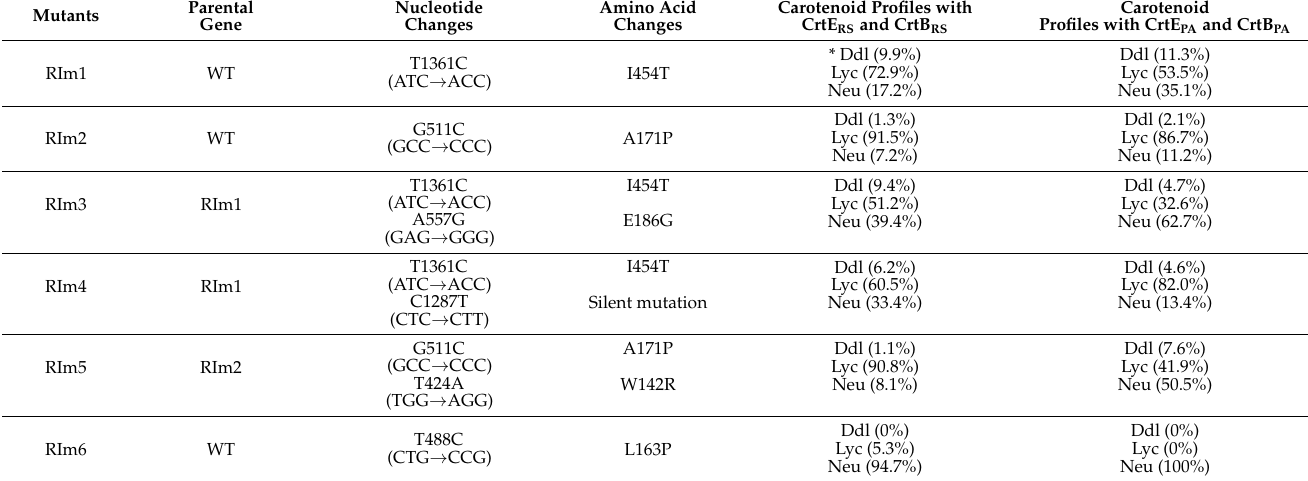
Table 2. CrtI RS mutants generated by random mutagenesis and altered carotenoid profiles when complemented with the R. sphaeroides CrtB RS and CrtE RS and the P. agglomerans CrtB PA and CrtE PA . * Neu, neurosporene; Lyc, lycopene; Ddl, didehydrolycopene. Proportions reported in parentheses: relative ratio of carotenoid